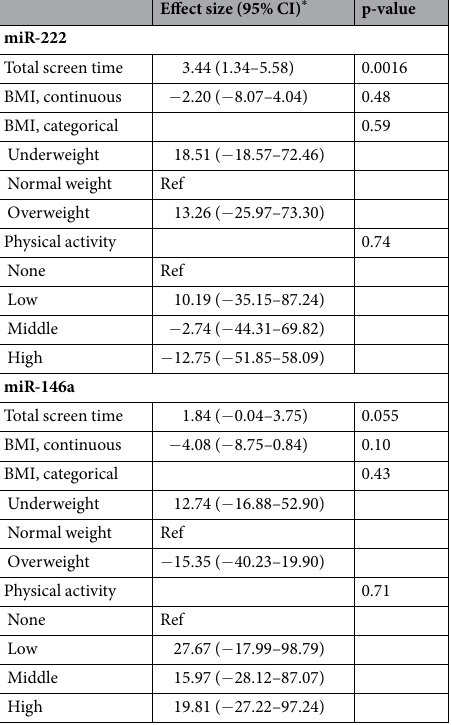
Table 2. The estimated changes in miR-222 and miR-46a associated with screen time, BMI and physical activity as evaluated in separate models. * Effect sizes represent the mean% change with the 95% confidence intervals in miRNA for a 1-hour increment in weekly screen time/1 kg/m² increase in BMI or compared to a reference group. Models were adjusted for gender, age, passive smoking exposure, maternal education and RNA content of the extracellular